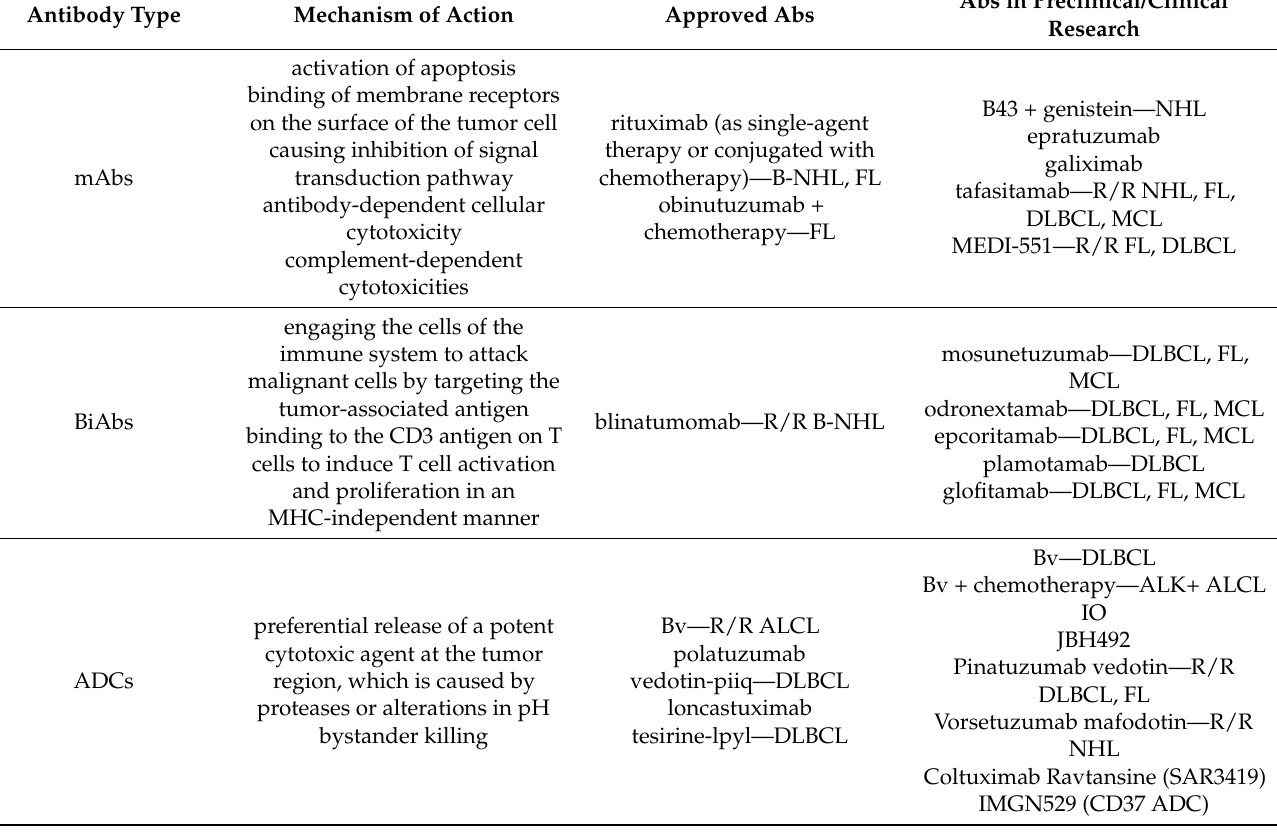
Table 4. Comparison of antibodies used in the treatment of pediatric NHLs